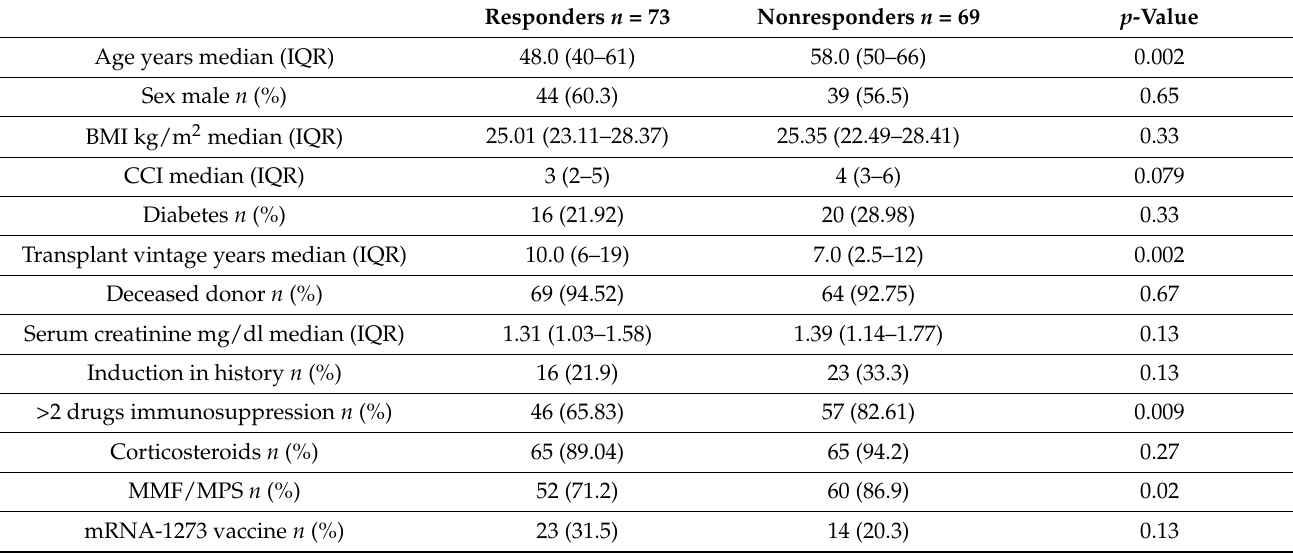
Table 2. Univariable analysis of predictors for anti-s IgG seroconversion.